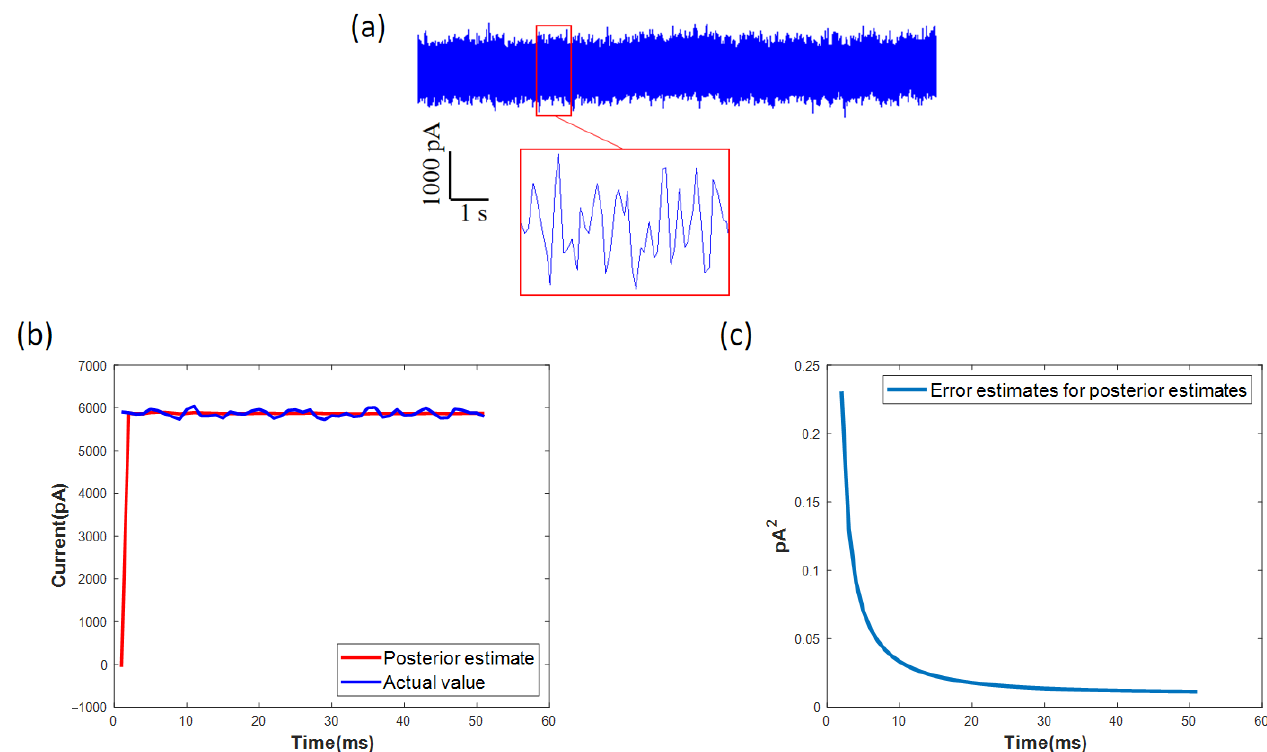
Figure 6. After wavelet processing, then the signal is processed by Kalman filter: ( a ) part of the current signal; ( b ) the wavelet transform improves the accuracy of Kalman filtering, makes the estimated value of Kalman filtering tend to the real value, and ensures the accuracy of data estimation; ( c ) in the long-term estimation, the Kalman filter maintains a stable and small error, and has a great effect on the noise reduction of the nanopore signal.